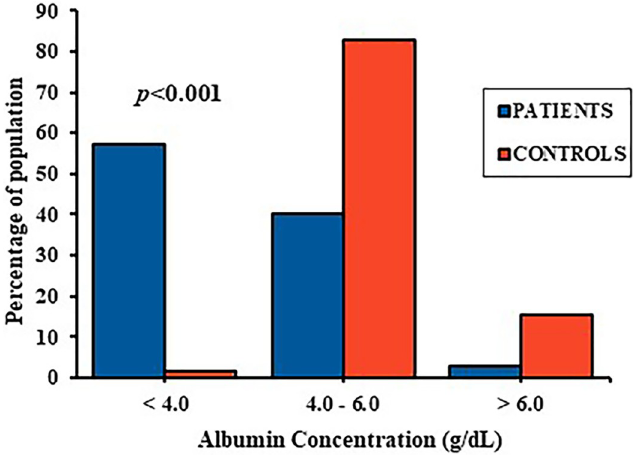
Fig 1. Distribution of human serum albumin (HSA) levels within the ACS patient group and control group.